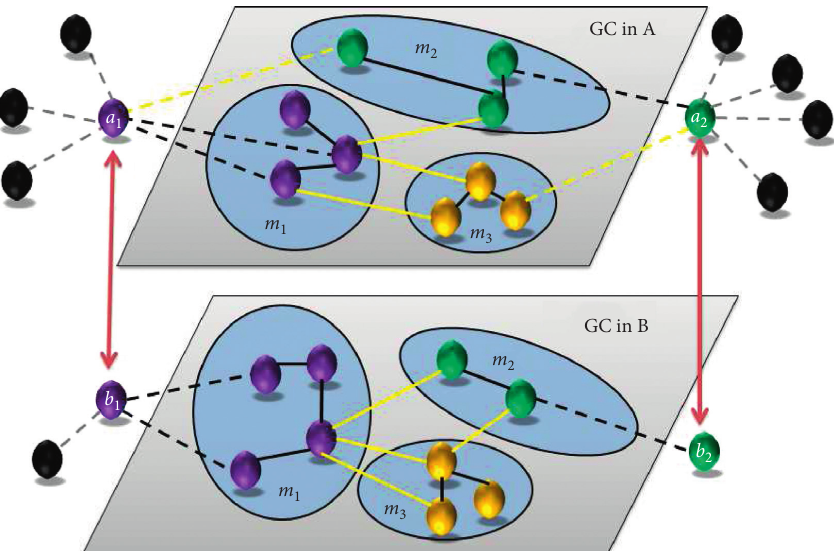
Figure 3: An example of the recovery strategy based on community structures. There are two pairs of mutual boundary nodes, ( a b 2 ), in subnetwork A and subnetwork B. The purple circles belong to the community m 1 , the green circles belong to m 2 , the orange circles belong to m 3 , and the black circles mean failed nodes that have no direct connection to the GC. In this example, the parameter β is assigned to 0.3. The value of R ( a 1 , b 1 ) � 3.1iscomputed by k intra ,thenumberofinactiveintracommunitylinks thatareconnectedtothe GC(black-dottedlines),and k inter , the number of inactive intercommunity links that are connected to the GC (yellow dotted lines) for the nodes a 1 and b 1 . The example assigns k intra ( a 1 ) � 2, k inter ( a 1 ) � 1, k intra ( b 1 ) � 2, and k inter ( b 1 ) � 0. The value of R ( a 2 , b 2 ) � 1.7 is computed in the same way. The results of R ( a 1 , b 1 ) and R ( a 2 , b 2 ) show that the pair of nodes a 1 and b 1 needs to be recovered. Furthermore, the links (black- and yellow-dotted lines) of a 1 and b 1 within their GC are